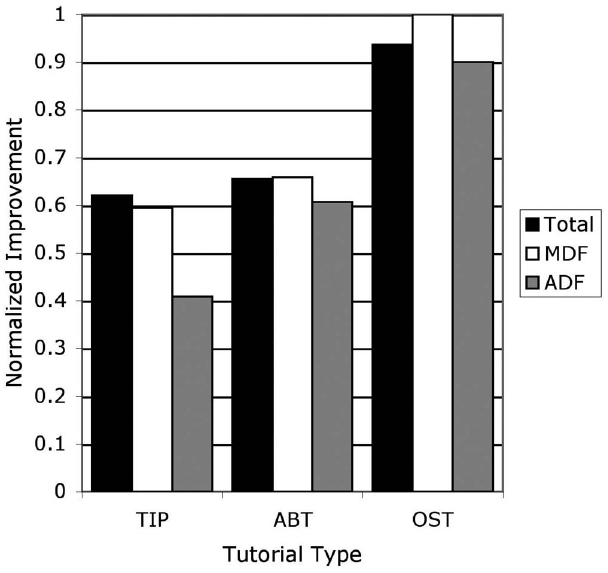
FIG. 4. FMCE data, collision situations in N3. Comparisons of three curricula, with separate columns for normalized gain on col- lision questions, improvement (cid:1) fractional possible gain (cid:2) in use of MDF, and improvement in use of